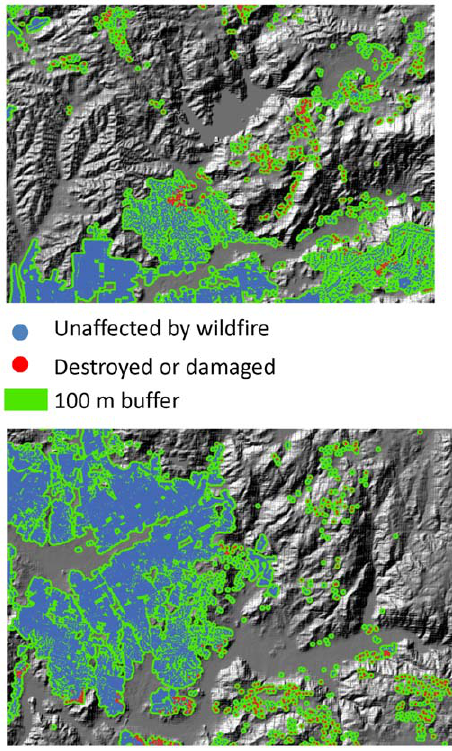
Figure 3. Maps from portions of San Diego County illustrating how housing arrangement influences the likelihood that a house will be lost from wildfire. Structures most likely to be burned by fires (in red) were: in areas with low to intermediate structure density; in small, dispersed housing clusters, close to the edge of the housing cluster, at intermediate distance to the nearest structure or housing cluster than structures that were unaffected (in blue).